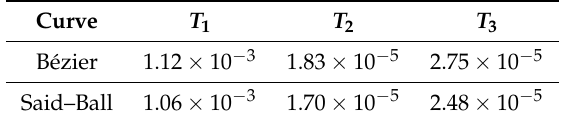
Table 5. The detailed runtime of WPIA, DWPIA and PPIA in Example 3. Curve